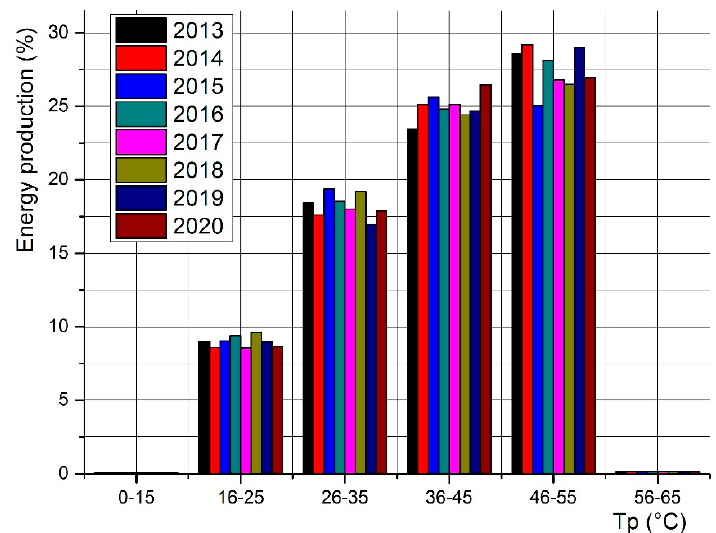
Figure 4. Percentage of energy production in the different backsheet temperature classes during the 8-year period.